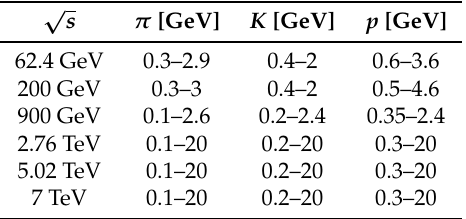
Table 2. Fitting p T ranges of spectra for different charged particles in pp collisions